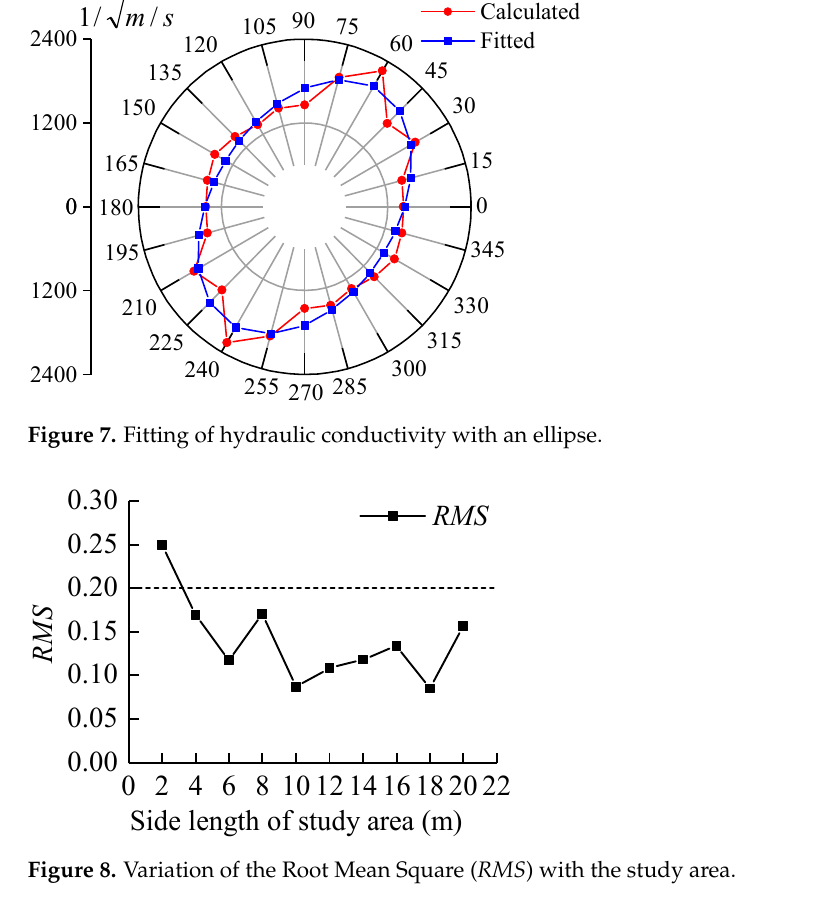
Figure 9. The REV of the fractured rock mass. The shape of the point indicates the fracture spacing, and the vertical bar area shows the fracture length. a After Zhang [33].